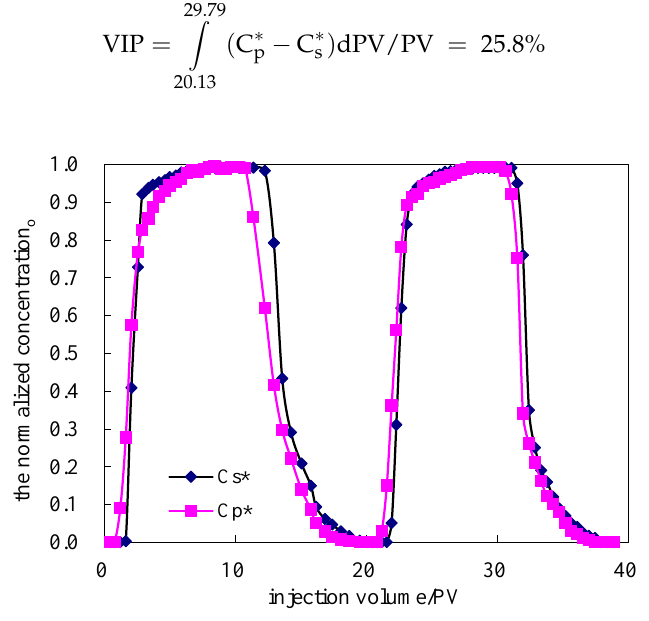
Figure 10. The concentration profile of polymer and tracer.